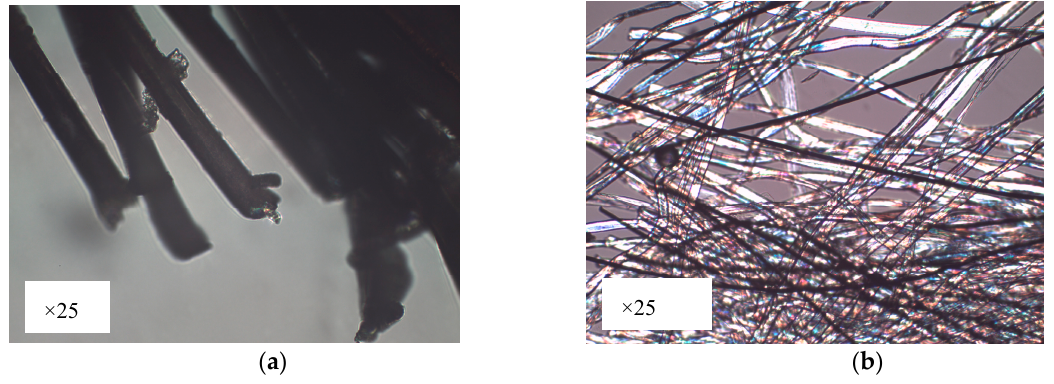
Figure 2. Microscope image of the used conductive yarns ( a ) Shieldex: this yarn is made of polyamide (PA) (inner) coated with pure silver (outer); ( b ) Bekaert: This yarn is made by mixing fibers (white fibers) of cotton with stainless steel (black fibers).